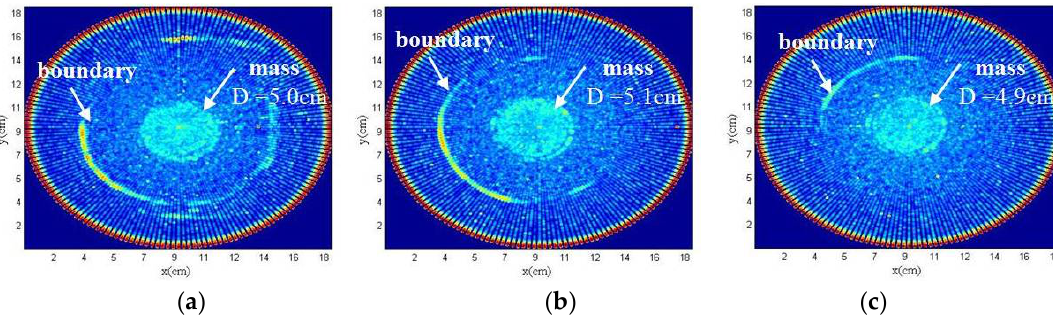
Figure 11. Ultrasonic tomography of breast model using the ring system. ( a ) Slice N = 30; ( b ) Slice N = 50; ( c ) Slice N = 70.